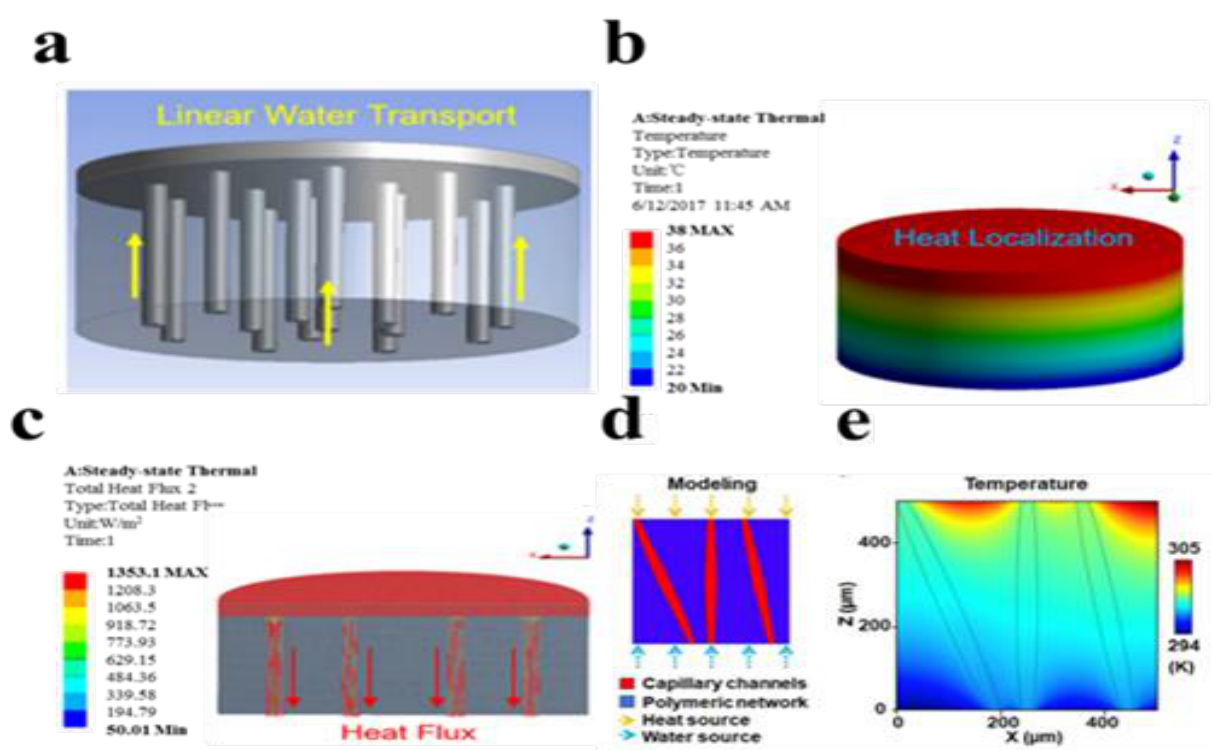
Figure 7: Numerical simulations for thermal management: (a) bottom view; (b) temperature distribution and (c) Heat flux distribution of the CG-HG evaporator [78]; (d-e) temperature distribution of CTH